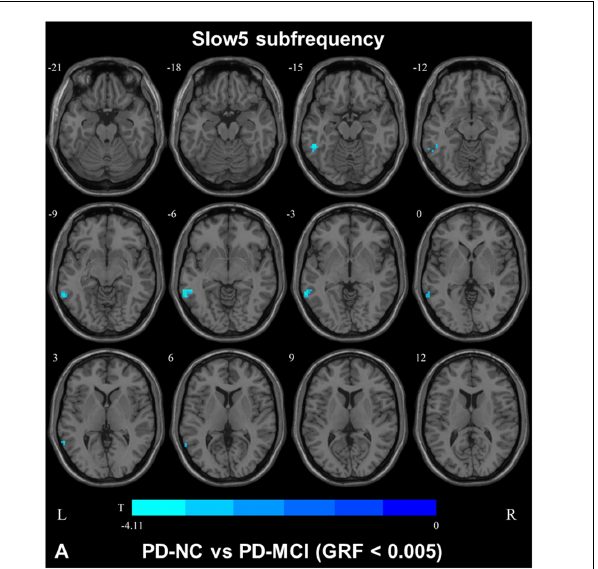
FIGURE 3 | DC map differences among the groups in slow5 subfrequency band. The DC results were compared by two sample t -tests (GRF corrected, voxel p < 0.005, cluster p < 0.05). The color bar on the bottom indicates the statistical t value. The cold color indicates a significantly decreased distant DC in the comparison. Additional details regarding these regions with difference are shown in Table 2 . (A) Decreased DC in PD-NC patients between PD-NC and